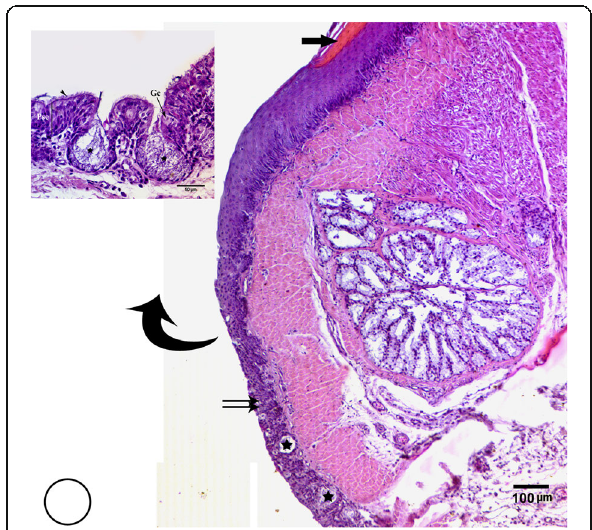
Fig. 11 Photomicrograph of a transverse section of common moorhen shows the epithelium roof is keratinized (arrow) then extends dorsally and changes gradually into pseudostratified ciliated columnar epithelium (double arrows) with simple alveolar gland (star). Upper left shows pseudostratified columnar epithelium (Psc) with cilia